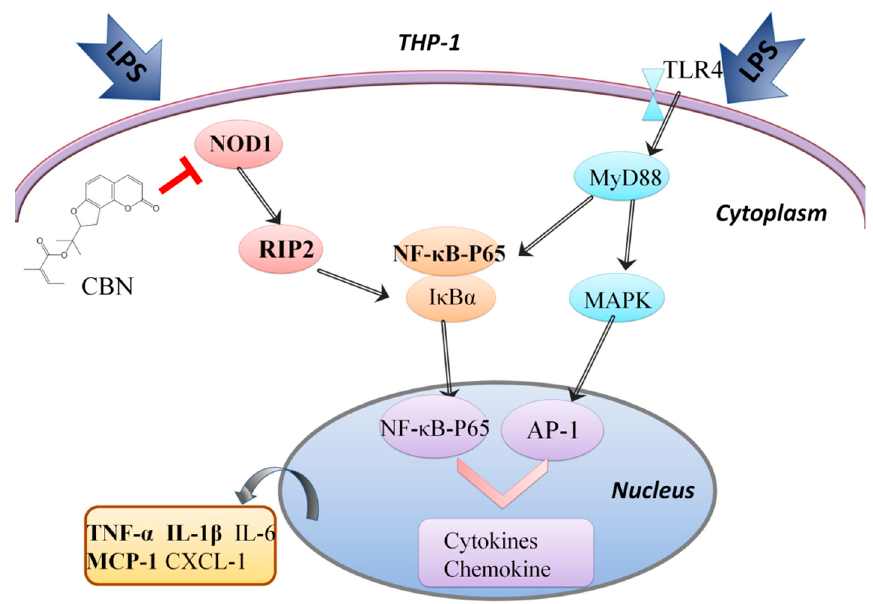
Figure 6. The NOD1 and TLR4 signaling pathways and the main target of CBN in the suppression of LPS-induced inflammation.